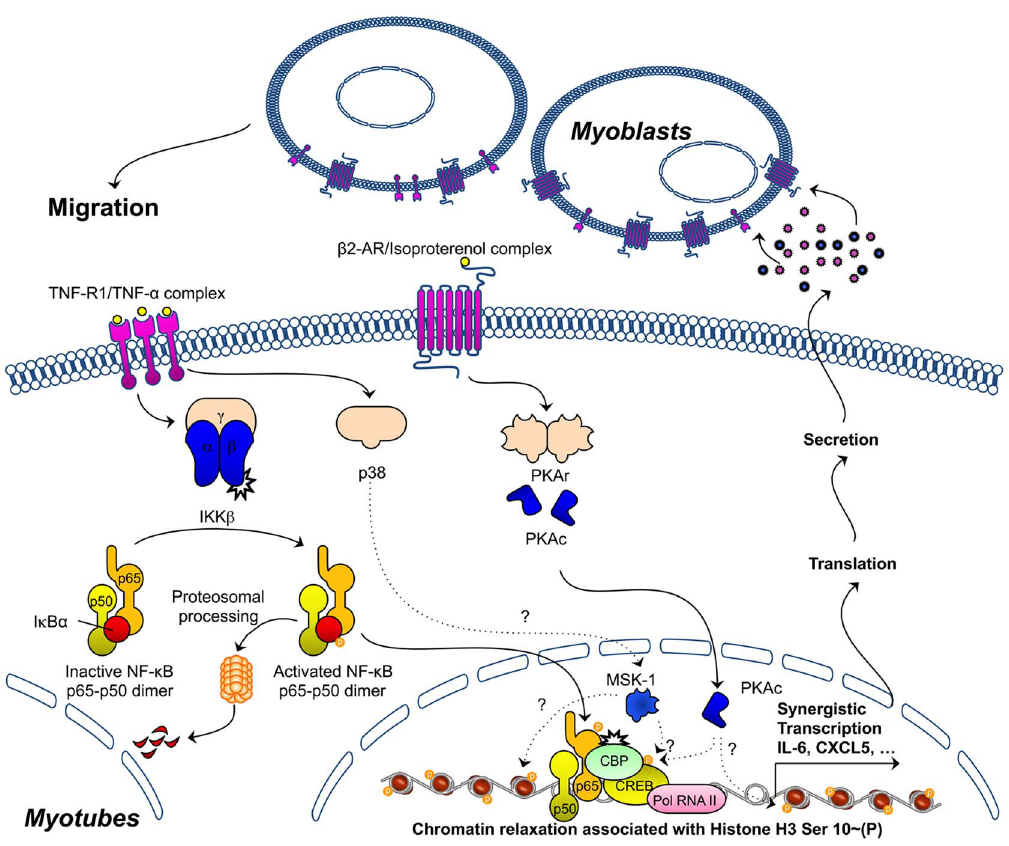
Figure 7. Model describing signalling events that are associated with b 2-AR/TNFR coactivation in C2C12 cells, ultimately leading to transcriptional synergy at selected NF- k B-dependent promoters. For a detailed description we refer to the text in the discussion. Dotted lines indicate connections that are based on correlations and hence should be interpreted as assumptions rather than proven facts.